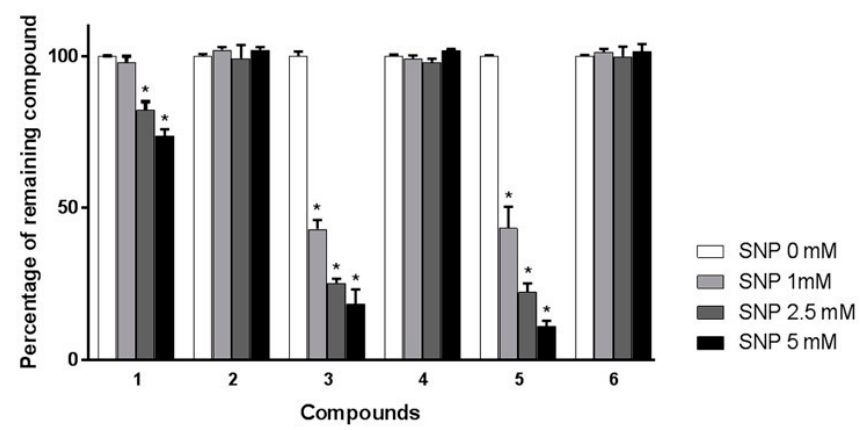
Figure 2. Percentage of remaining compounds ( 1 – 6 ) after incubation of aqueous extract from Aloysia triphylla leaves with various concentrations of SNP (0, 1, 2.5, and 5 mM). Data are presented as means ± SEM ( n = 3). * p < 0.05 vs. control (SNP = 0 mM).